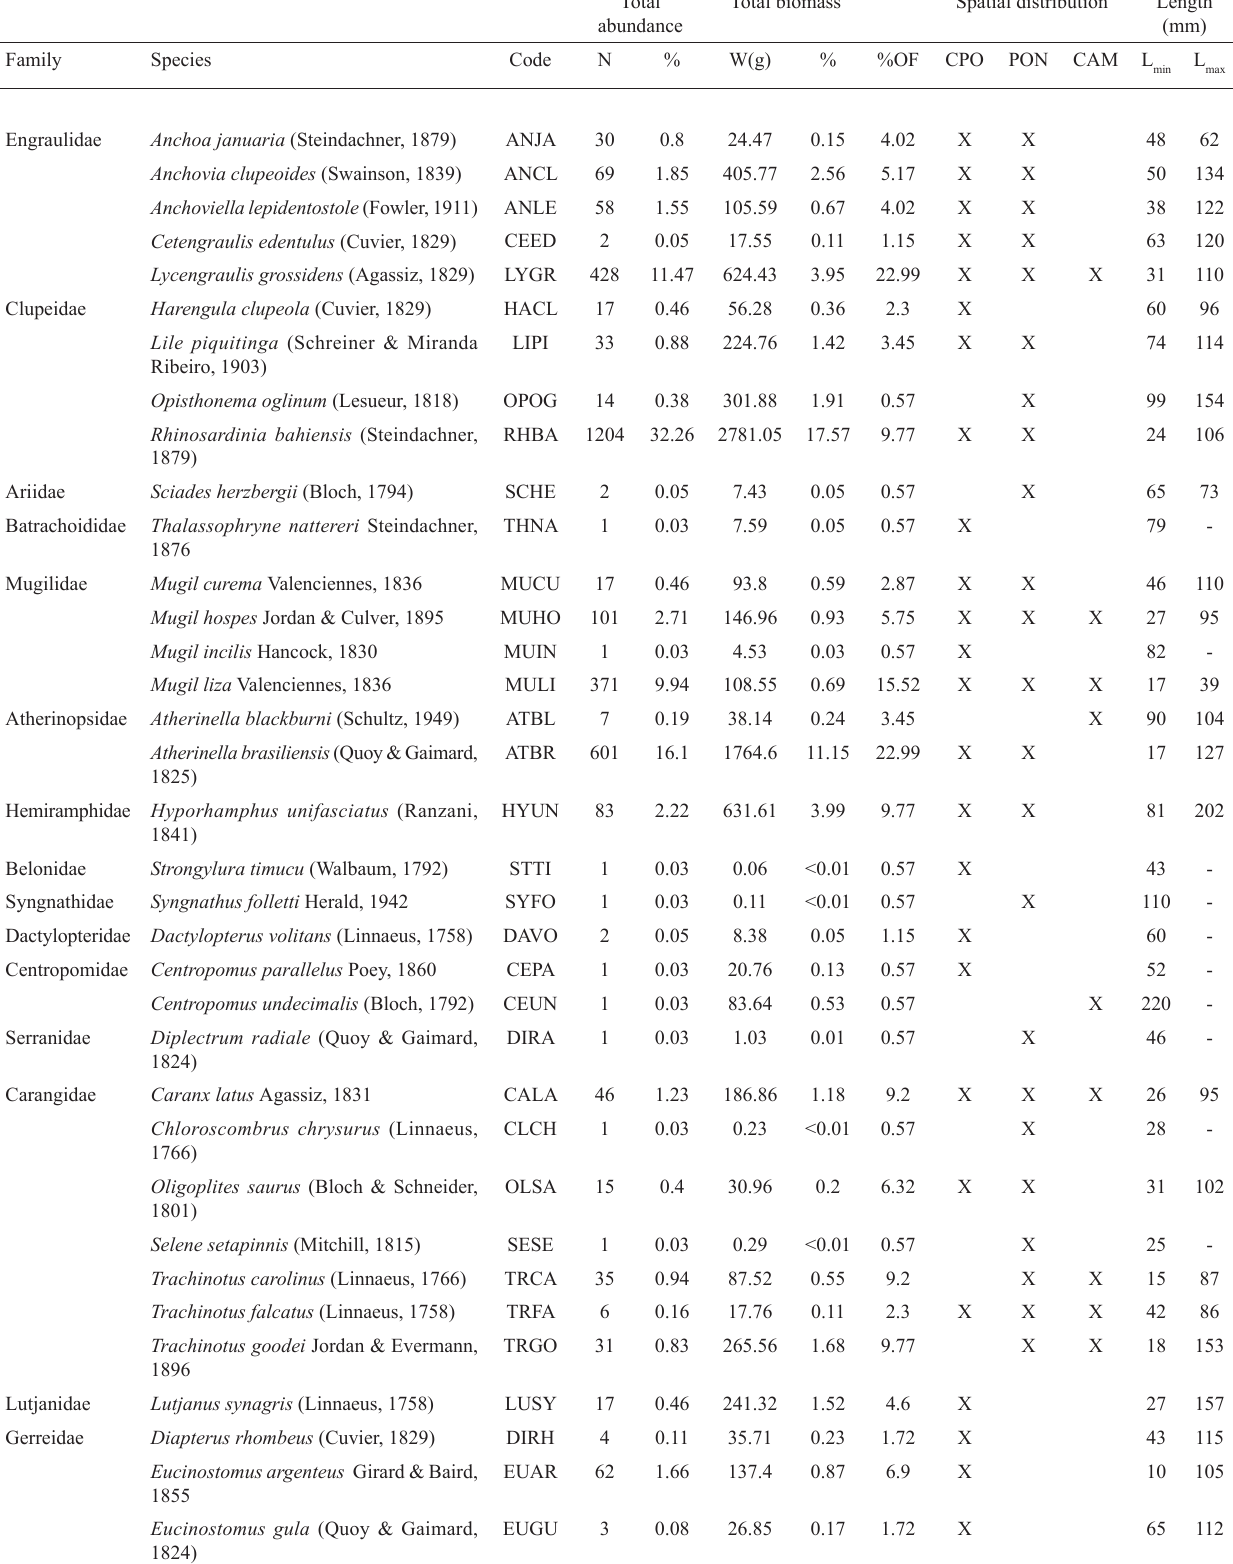
Table 2. Numerical abundance, biomass, frequency of occurrence, spatial distribution and maximum and minimum length of fish species captured on three beaches in the Mamanguape River estuary of Brazil. The species are ordered in accordance with Nelson